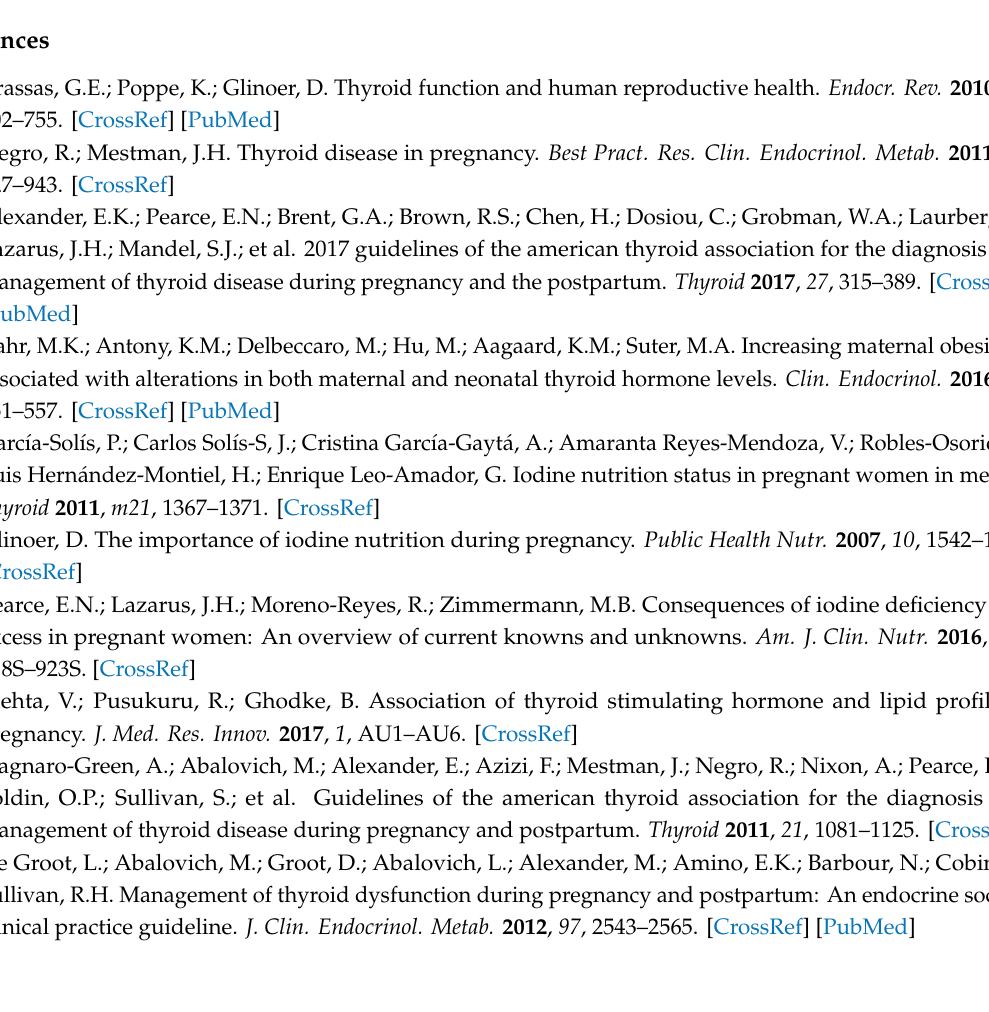
Table S1: Classification according to thyroid pathology, Table S2: Features presented with the mean ±